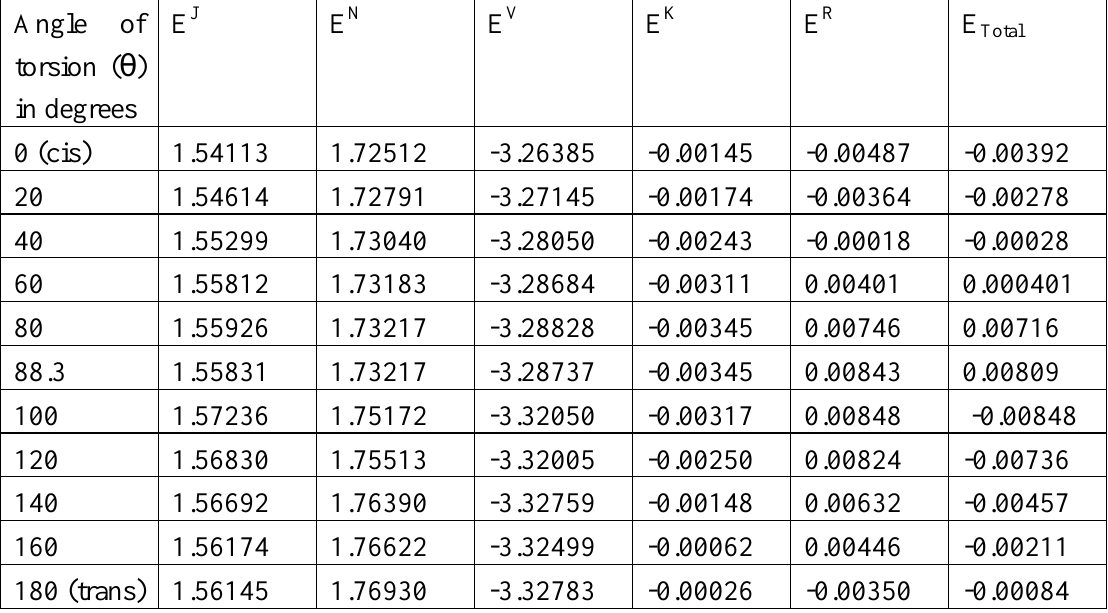
Table 6. The ‘O----H ‘ non-bonding interaction (a.u) in Hydrogen Peroxide with torsion. Angle